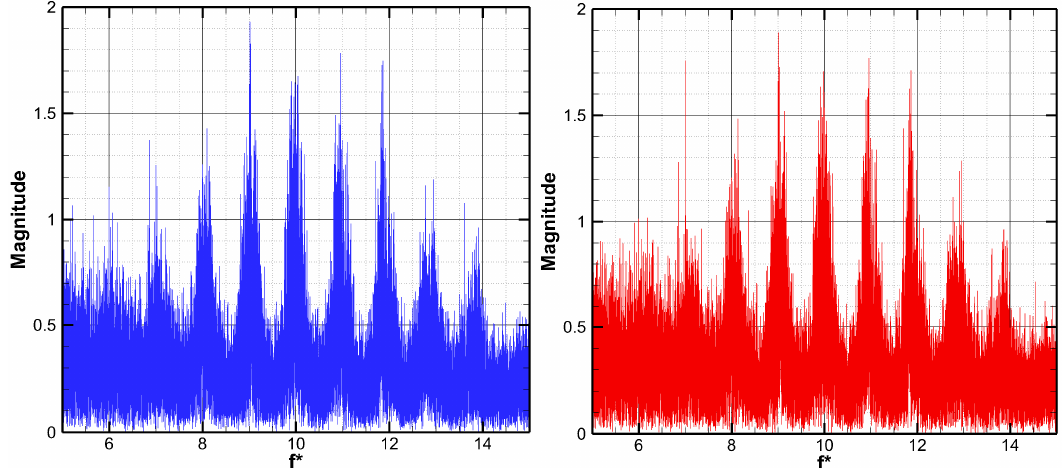
Figure 5. FFT of pressure signals from Transducer 2, Case 1 ( 𝒎(cid:4662) 𝒑𝒖𝒓𝒈𝒆 is 0.28%).